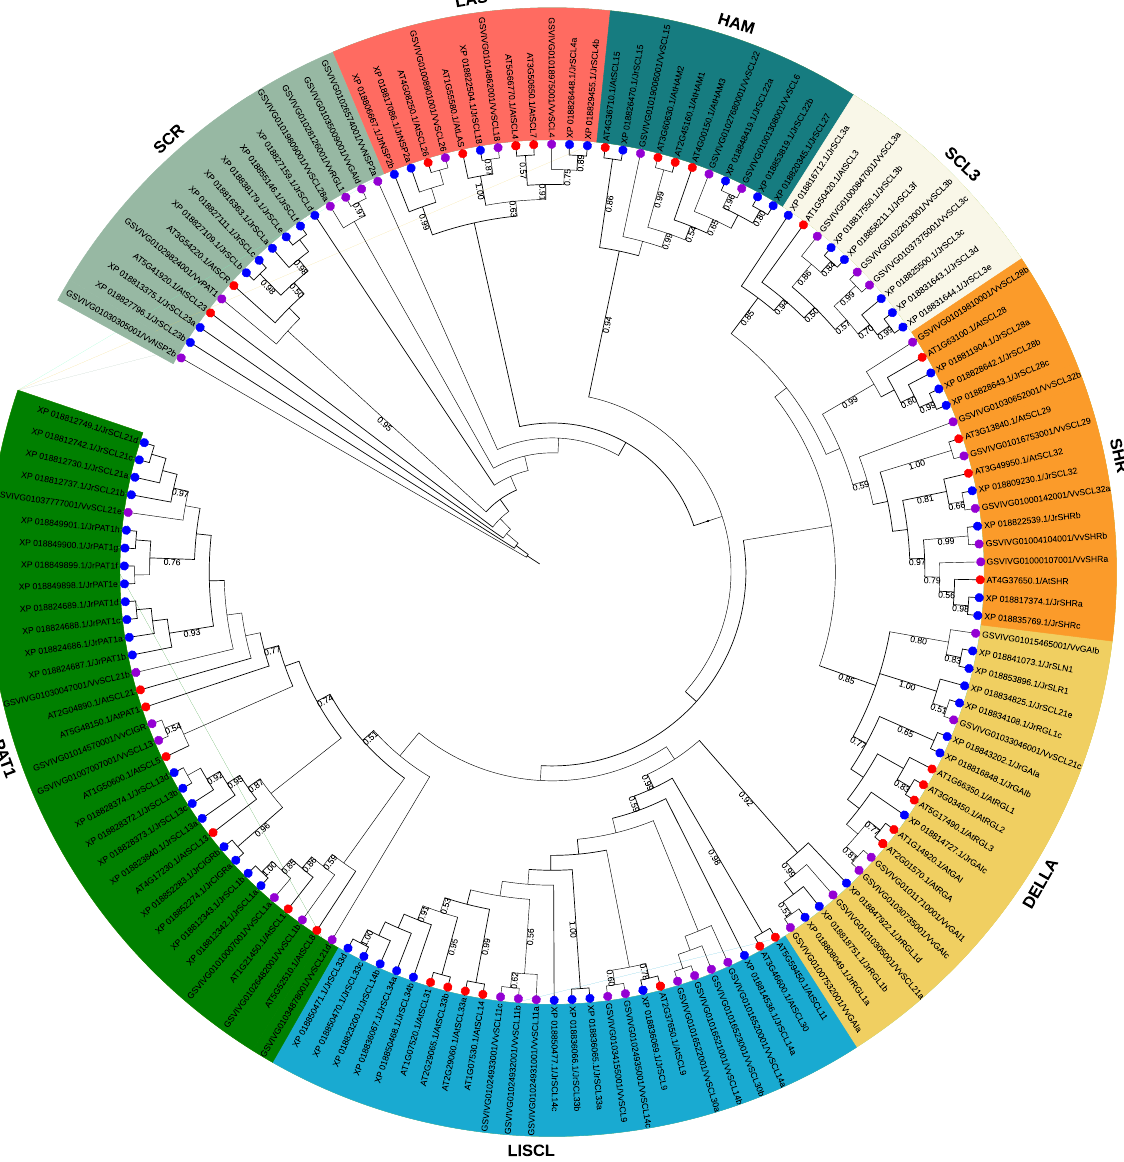
Figure 1. Phylogenetic tree of the domain sequence of GRAS proteins from Arabidopsis, walnut and grape using the Maximum Likelihood method. Genes in Arabidopsis, walnut and grape are labeled in red, blue and purple dots,